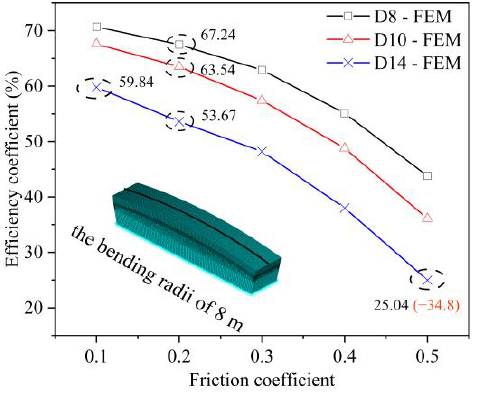
Figure 17. Curves of friction coefficient and efficiency coefficient.